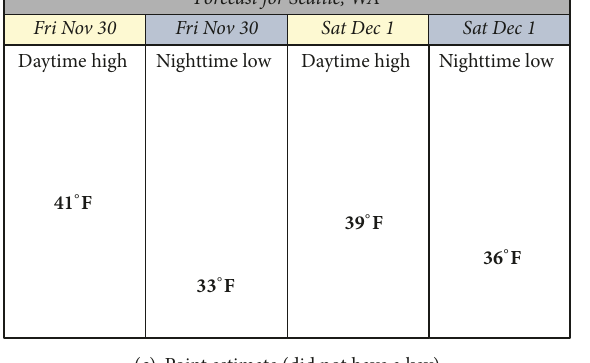
Figure 1: Visualizations used in the temperature decision task in Experiment 1. Font sizes are slightly smaller in this figure than they were in the experiment to conform to journal